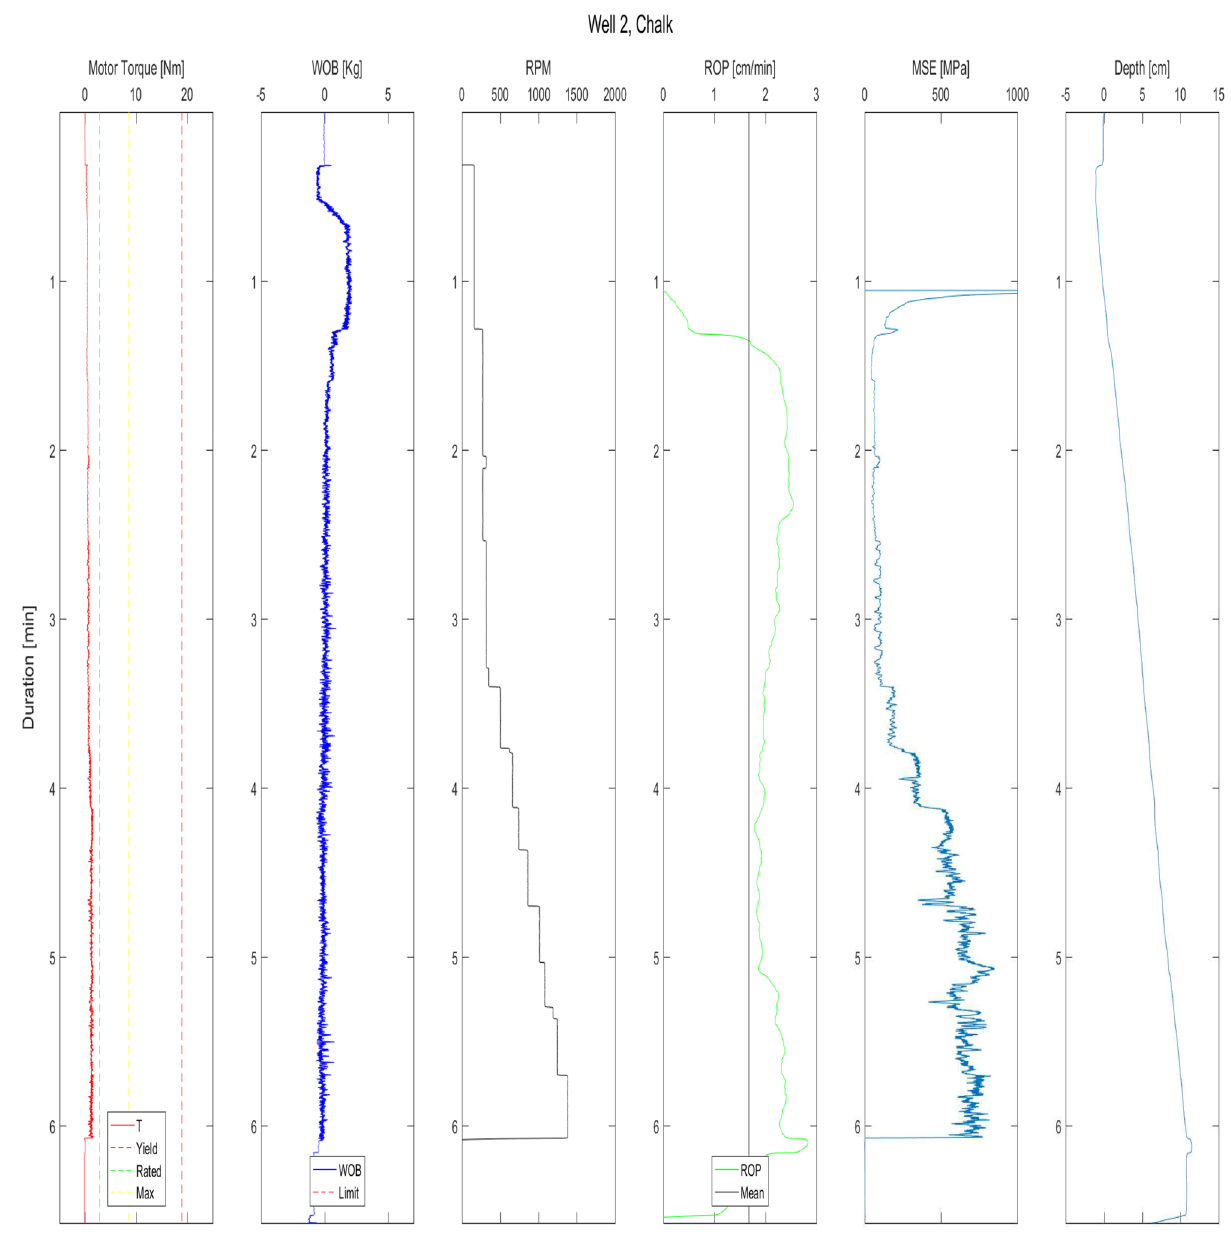
Fig. 6 Well Chalk 2, manual mode with varying